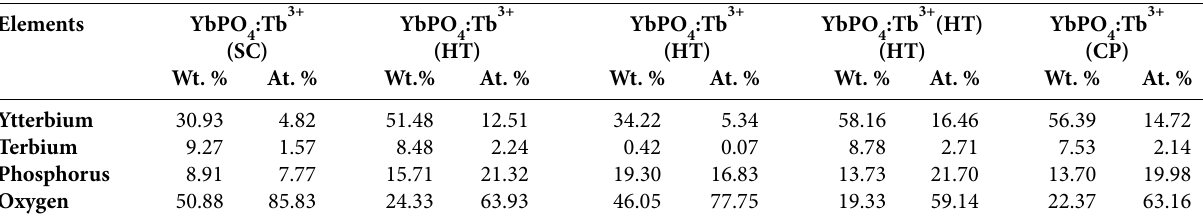
Table 1. Atomic and Weight % of elements present in YbPO 4 :Tb 3+ nanostructures Elements